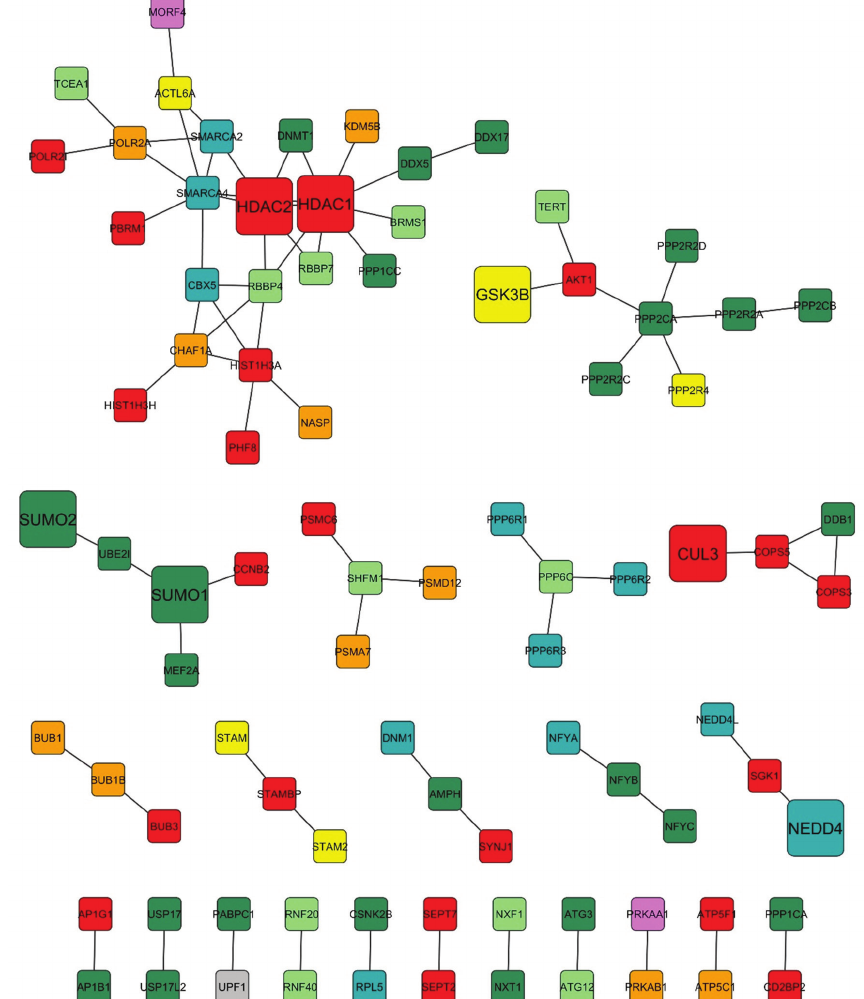
Figure S3. Complete human UBA1 primary gene interaction network representing 22 clusters. Human orthologs of yeast genes identified from four independent SGA screens were used to map the corresponding protein-protein interaction network.